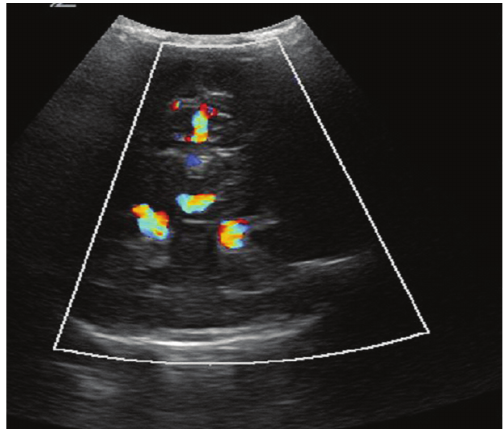
Figure 7: Colour duplex sonography after first embolization: no cystic mass is visible any more.